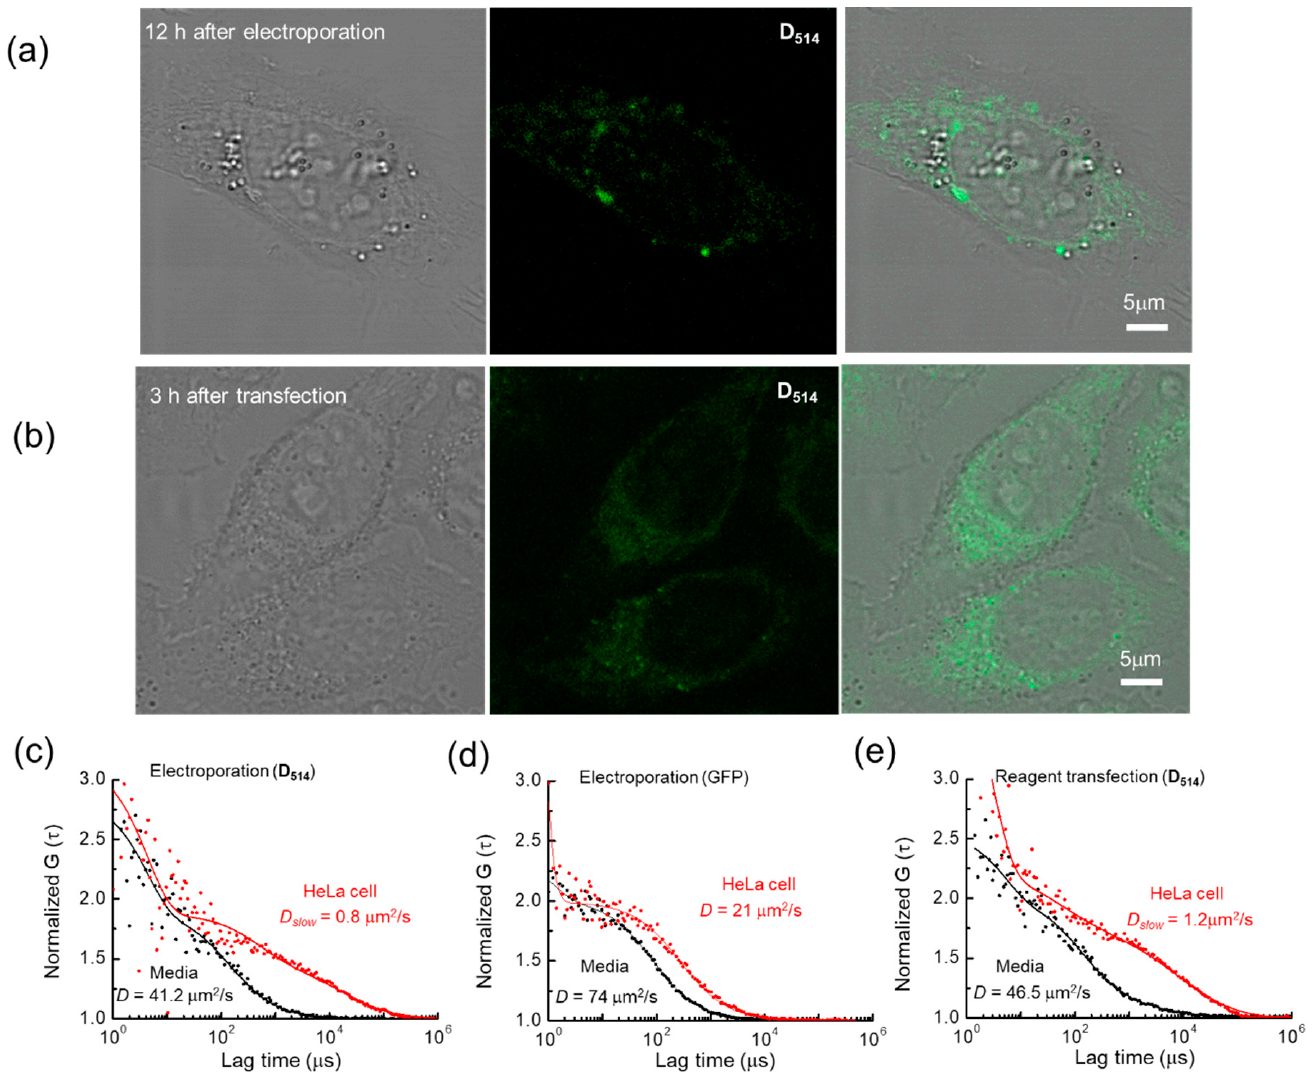
Figure 4. FCS analysis of live HeLa cells transfected with the D 514 probe. ( a ) HeLa cell after 12 h of electroporation with the D 514 probe (scale bar: 5 µ m). ( b ) HeLa cell after 3 h of transfection with the D 514 probe (scale bar: 5 µ m). ( c ) Representative fluorescence auto-correlation function of the D 514 probe and ( d ) recombinant GFP molecule in live HeLa cells after electroporation. ( e ) Representative fluorescence auto-correlation functions of the D 514 probe in live HeLa cells after 3 h of transfection. The black and red curves (solid) are functions fit to the spectra from the culture medium and live cells, respectively. The D value of the D 514 probe obtained from the fitted curve is also shown (inset). For simplicity, only the diffusion coefficient of the slow component is shown to represent the mobility in the live cells.